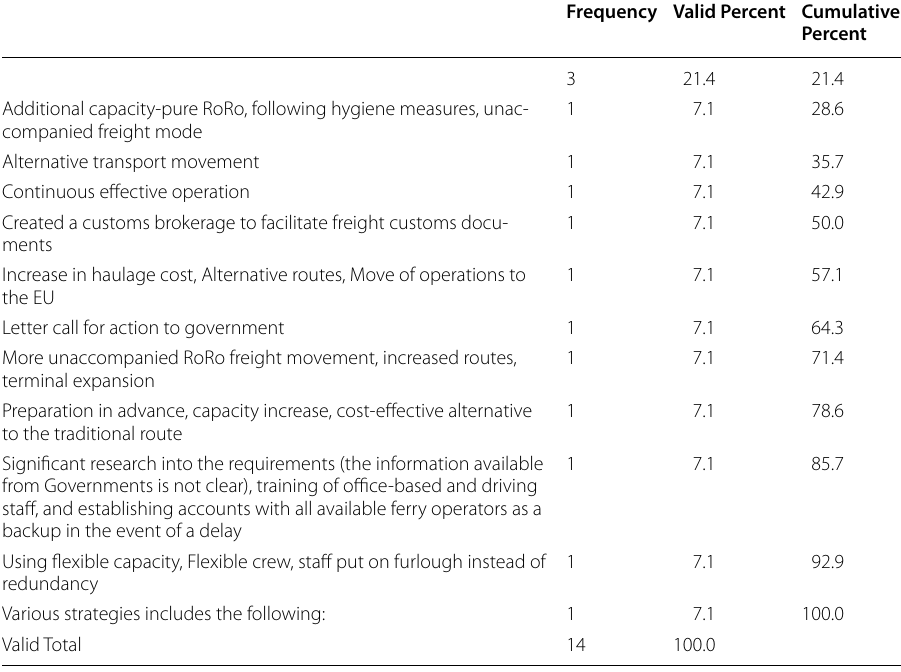
Table 9 Strategies implemented by respondent’s organisation for continuous freight movement despite the Brexit and Covid 19